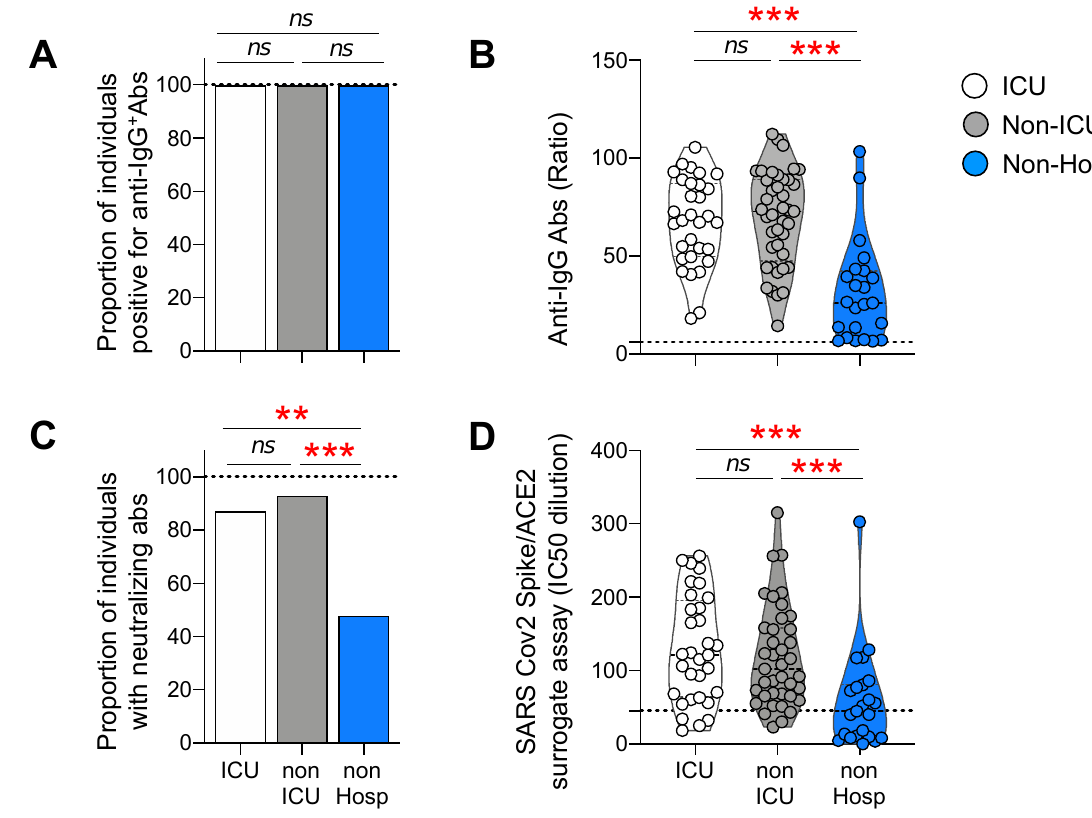
Figure 1. Antibody responses against the Spike protein in ICU, non-ICU, and non-hospitalized individuals. Luminex beads, coupled with Spike proteins, were used to monitor the IgG binding antibody response; neutralization was measured by a surrogate Spike/ACE-2 inhibition binding assay in the sera, from ICU (N = 31), non-ICU (N = 41), and non-hospitalized (N = 23) individuals at 6 months post-SARS-CoV-2 infection. The proportion of individuals with detectable ( A ) IgG ( C ) neutralizing antibodies in the three study groups. ( B ) Levels of IgG-binding antibody responses: MFI signals for serum antibody-binding were expressed as ratios, compared to a negative-control pool of pre-COVID-19 pandemic human serum, tested in parallel. ( D ) IC50 dilutions of the Spike/ACE2 surrogate neutralization assay. p -values were obtained using chi-square and a one-way ANOVA (Kruskal–Wallis test), followed by a Mann–Whitney test. Red stars indicate statistical significance (** = p < 0.001; *** = p < 0.001); ns = not significant. The cumulative data indicated that the frequencies of Spike (ICU = 1.2%; non-ICU = 1.13%, non-hospitalized = 0.44%), RBD (ICU = 0.69%; non-ICU = 0.8%; non-hospitalized = 0.28%), and N-specific (ICU = 0.78%; non-ICU = 0.74%; non-hospitalized = 0.33%) B cells were significantly reduced at 6 months POS in non-hospitalized individuals, compared to ICU or non-ICU-hospitalized individuals (Figure 2B–D). Notably, no significant differences were observed between the ICU- and non-ICU-hospitalized individuals ( p > 0.05) (Figure 2B–D). Overall, these data indicate that non-hospitalized individuals harbor reduced anti- SARS-CoV-2 memory B cells at 6 months POS, compared to ICU and non-ICU-hospitalized individuals. Moreover, no differences were found in the frequencies of anti-SARS-CoV-2 memory B cells at 6 months POS between ICU- and non-ICU-hospitalized